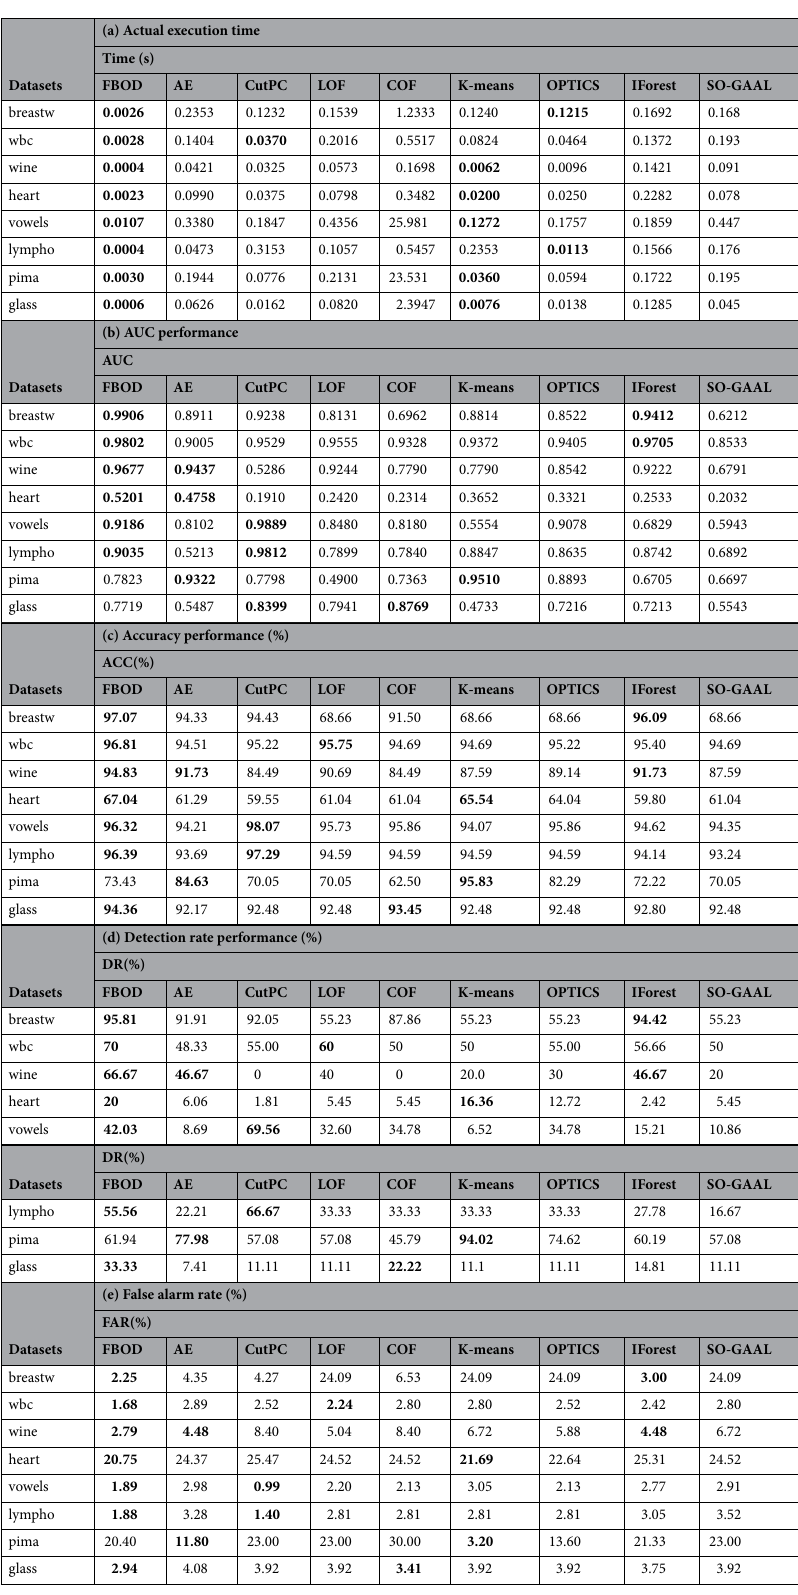
Table 4. Experimental results on real-world datasets. Values marked in bold are ranked by the top 2 in the